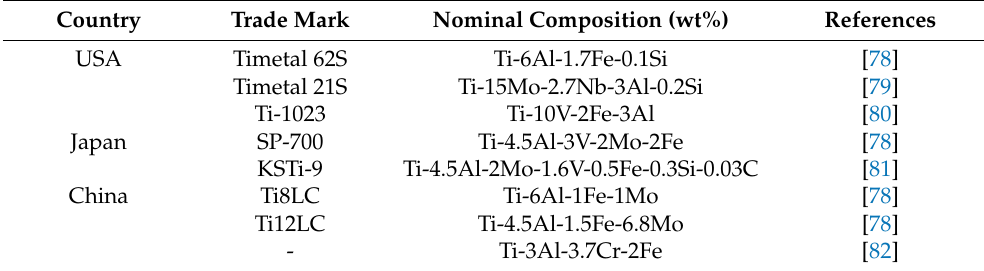
Figure 6. The ratio of V:Fe = 3.5:1 is recommended to design novel titanium alloys. Table 4. Some titanium alloys developed in various countries. Country Trade Mark Nominal Composition